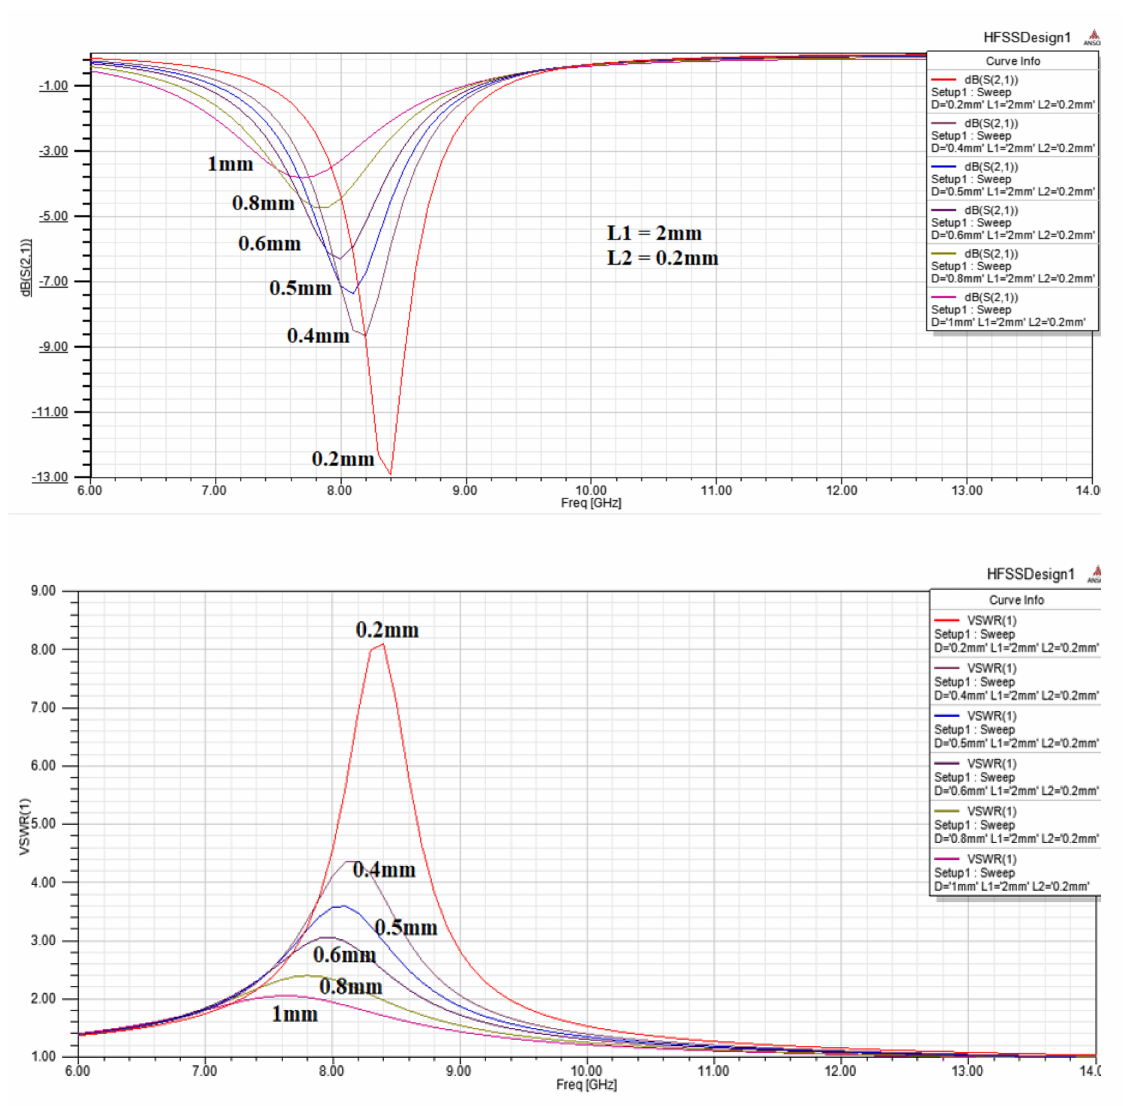
Figure 10. Transmission and voltage standing wave ratio (VSWR) curves with the thickness of the absorption disk as a